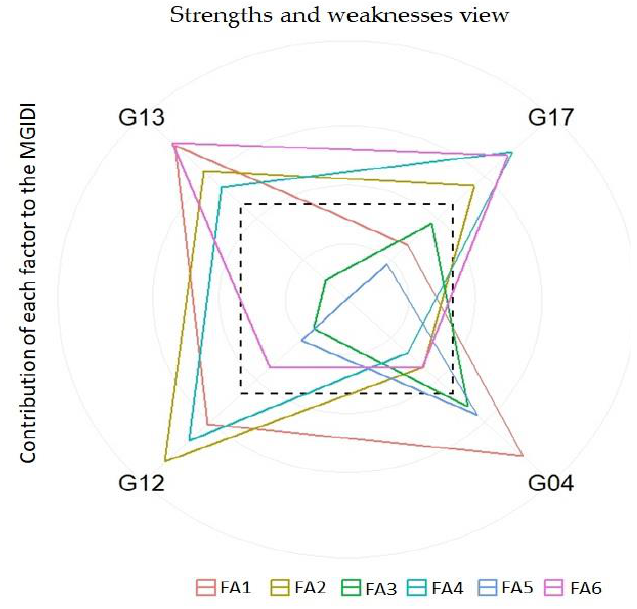
Figure 4. The strengths and weaknesses of the selected genotypes are shown as the proportion of each factor on the computed